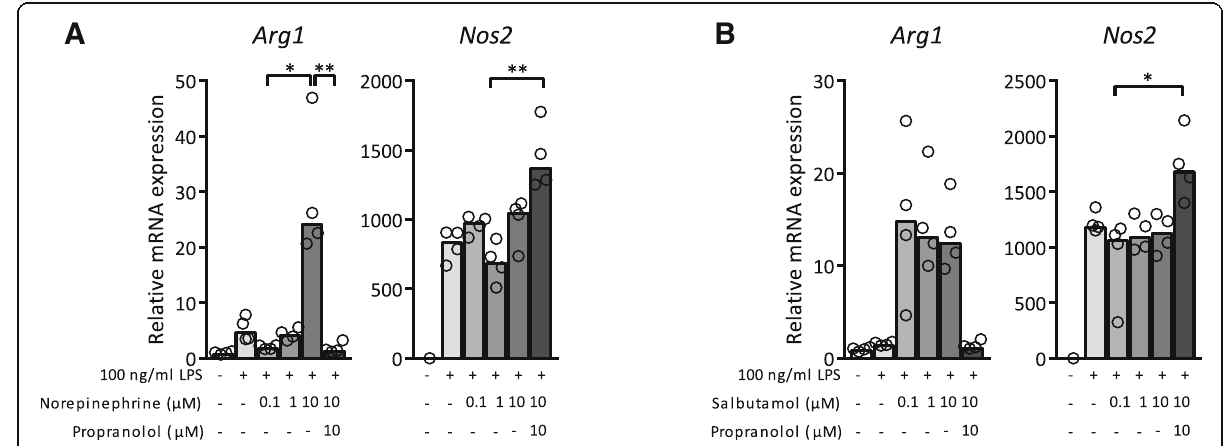
Fig. 2 Lipopolysaccharide (LPS)-exposed bone marrow derived macrophages (BMDM) had an increased anti-inflammatory phenotype after adrenergic receptor activation. mRNA expression levels of Arginase 1 (Arg1) and nitric oxide synthase 2 (Nos2) in cell lysate of BMDM after treatment with 100 ng/ml LPS for 18 h and pre-treatment with different concentrations of norepinephrine ( a ) or salbutamol ( b ) together with propranolol, normalized for reference genes β -actin and Ubiquitin. Expression is relative to mRNA expression in BMDM not exposed to any treatment. N = 4 mice. Data is expressed as median and individual data points. We tested for statistical significant differences with a Kruskal-Wallis test and post-hoc Dunn ’ s test. P -value < 0.05 was considered significant. * P -value < 0.05; ** P -value ≤